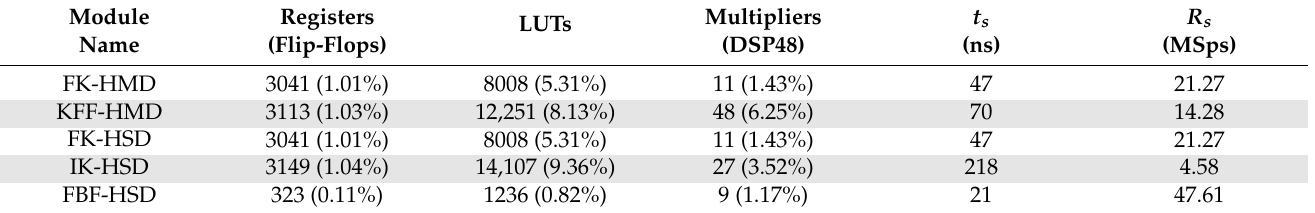
Table 2. FPGA resource utilization, sampling rate and throughput results for floating-point